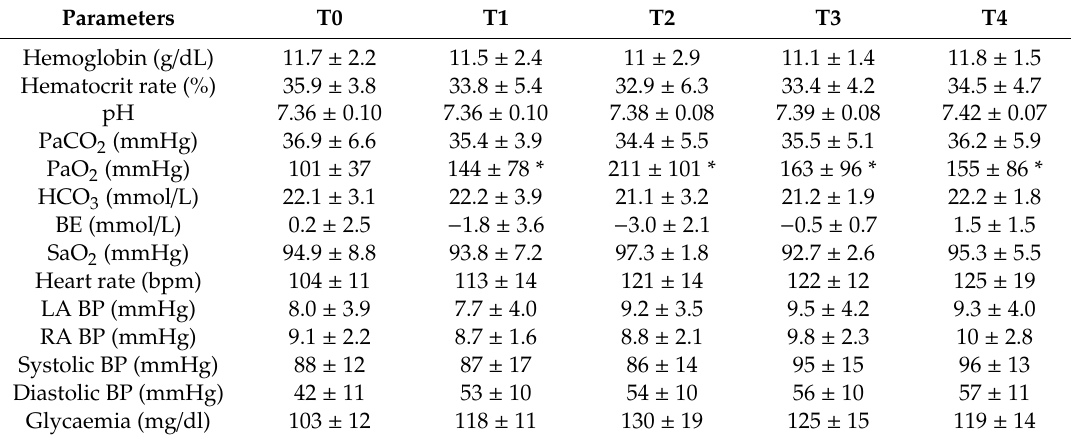
Table 2. Laboratory parameters at different monitoring time points (before the surgical procedure, T0; during the surgical procedure before CPB, T1; at the end of CPB, T2; at the end of the surgical procedure, T3; 24 h after the surgical procedure, T4) in children admitted into the study. Data are given as mean ± SD.